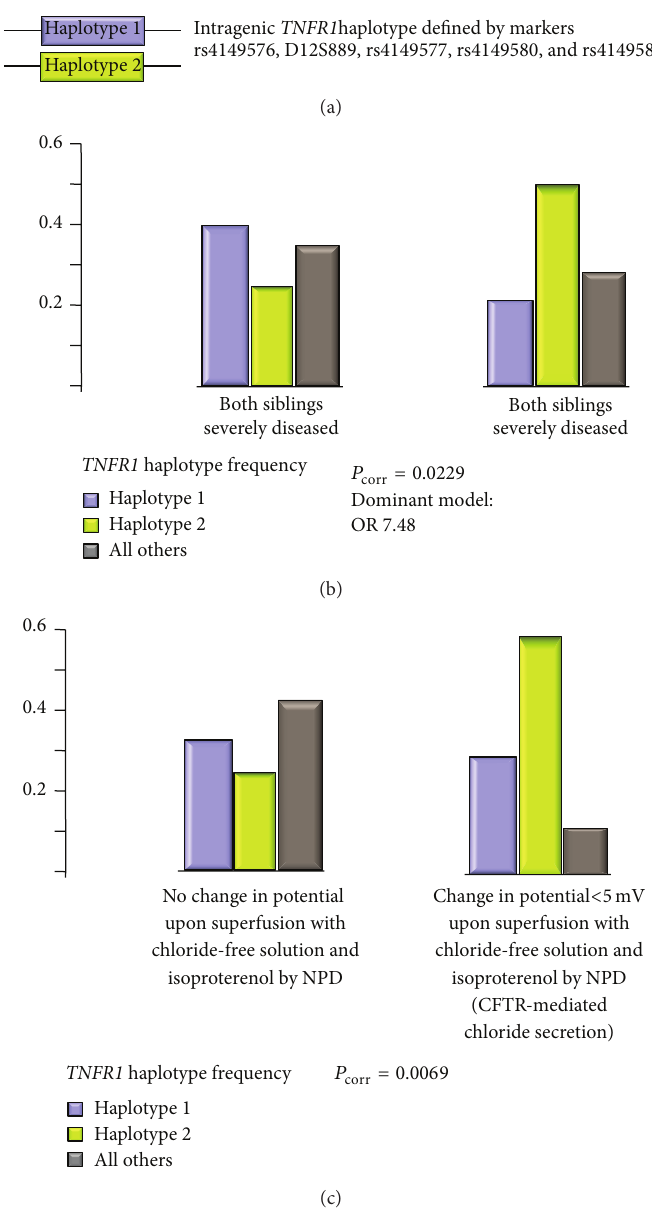
Figure 1: Association of TNFR1 variants with CF disease severity and manifestation of CFTR-mediated residual chloride secretion in respiratory tissue among F508del- CFTR homozygous CF patients. (a) Definition of TNFR1 variants. Two contrasting haplotypes,